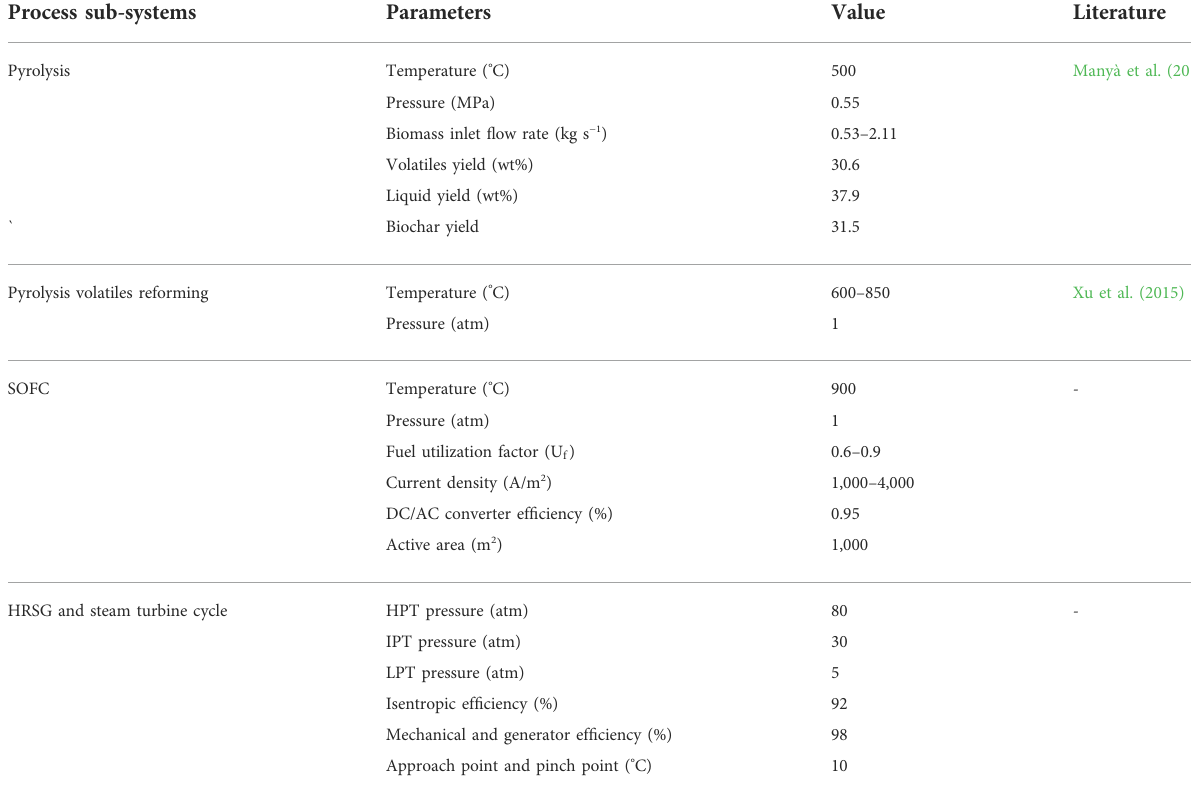
TABLE 2 Operating conditions used in the simulation.